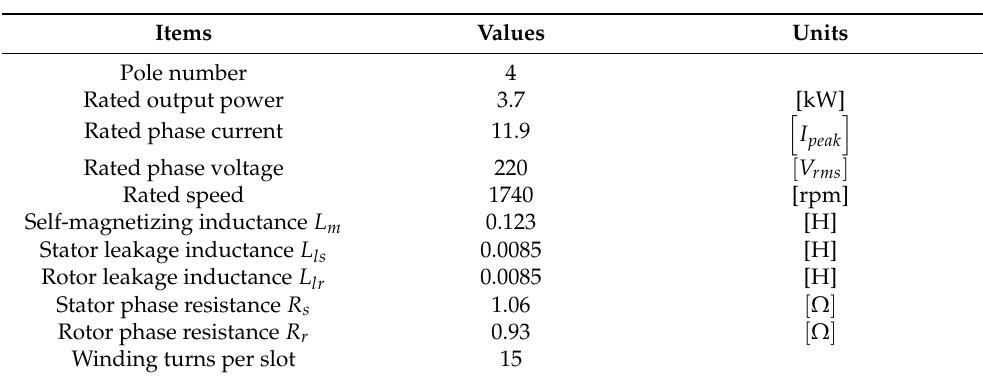
Table 1. Motor specifications.